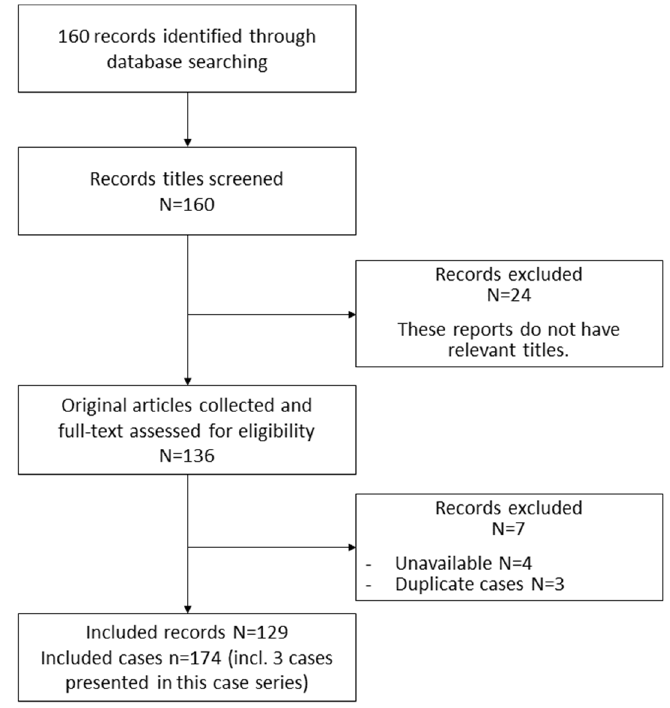
Figure 1. Selection flowchart.